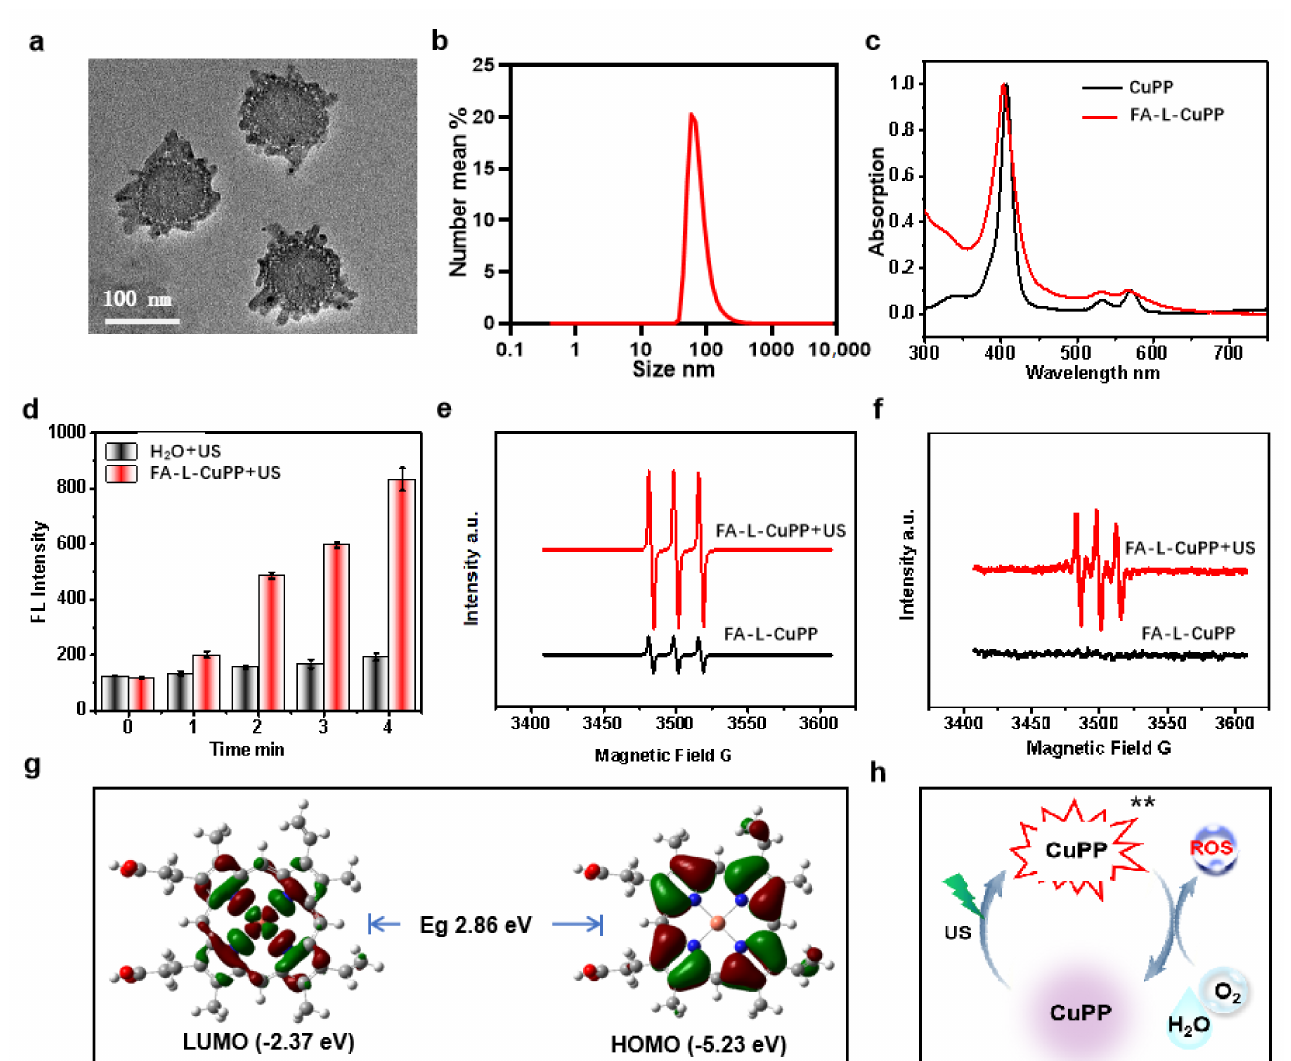
Figure 2. Characterization and US-responsive behavior of FA–L–CuPP under US treatment (1.0 W · cm − 2 , 50% duty cycle): ( a ) TEM images of FA–L–CuPP, showing urchin − shaped struc- tures. ( b ) The size distribution of the FA–L–CuPP determined by DLS. ( c ) UV − Vis spectra of the nanoparticles of FA–L–CuPP, showing the same S − and Q − bands absorption from CuPP complex. ( d ) The FL signal intensity to detect the time − dependent 1 O 2 generation by US treatment (the concen- tration of CuPP complex: 40 µ g · mL − 1 ). ( e ) ESR spectra to detect 1 O 2 generation after US treatment using TEMPO as a probe, and 1 O 2 was significantly observed under US irradiation. ( f ) ESR spectra to detect · OH radical group after US irradiation using DMPO as a probe. ( g ) HOMO/LUMO orbitals of CuPP complex calculated by density functional theory (DFT) at the B3LYP Hybrid function, the 6-311G* (C, N, H, O) and def2tzvp (Cu) basis level. ( h ) Diagram illustration for the possible ROS generation mechanism under US